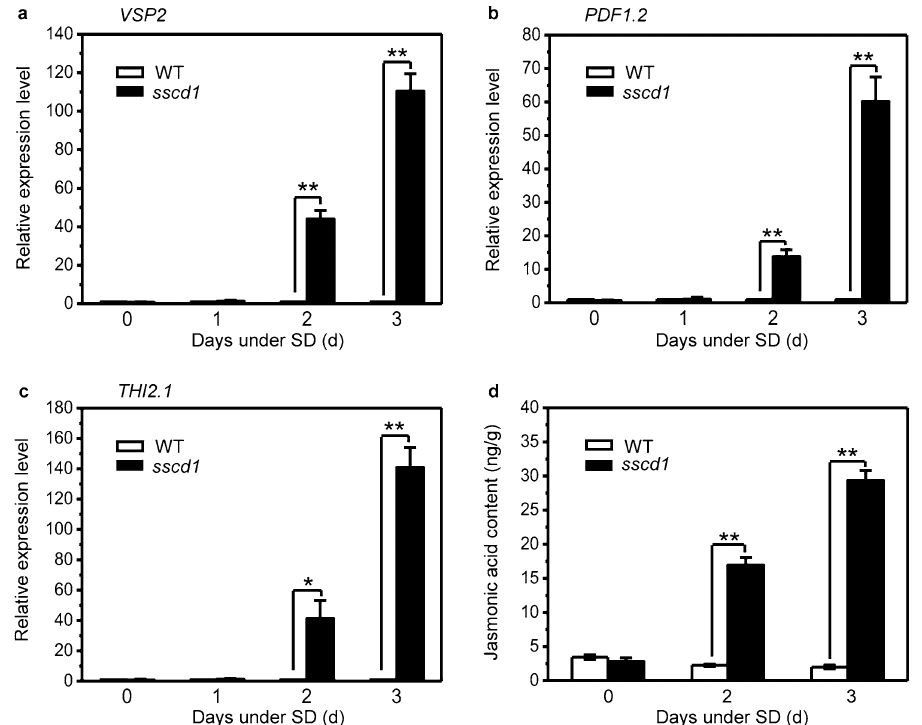
Figure 2. Cell death in sscd1 is accompanied by the up-regulation of JA-inducible genes and the accumulation of jasmonic acid. ( a – c ) Relative expression level of JA -inducible genes VSP2 ( a ), PDF1.2 ( b ), THI2.1 ( c ) in wild-type (WT) and sscd1 seedlings that were grown under LD for 3 weeks, and then transferred to SD for 0, 1, 2 and 3 days. ( d ) The content of jasmonic acid in wild-type (WT) and sscd1 seedlings that were grown under LD for 3 weeks, and then transferred to SD for 0, 2 and 3 days. LD, long day; SD, short day. The expression of genes was analyzed by RT-qPCR, relative expression level was normalized to those of ACTIN2 and the control (in wild type) was set to 1. Mean ± SE from three biological replicates. Asterisk * and ** represent the significance of differences (two-tailed Student’s t-test) at the levels of P < 0.05 and P < 0.01, respectively.